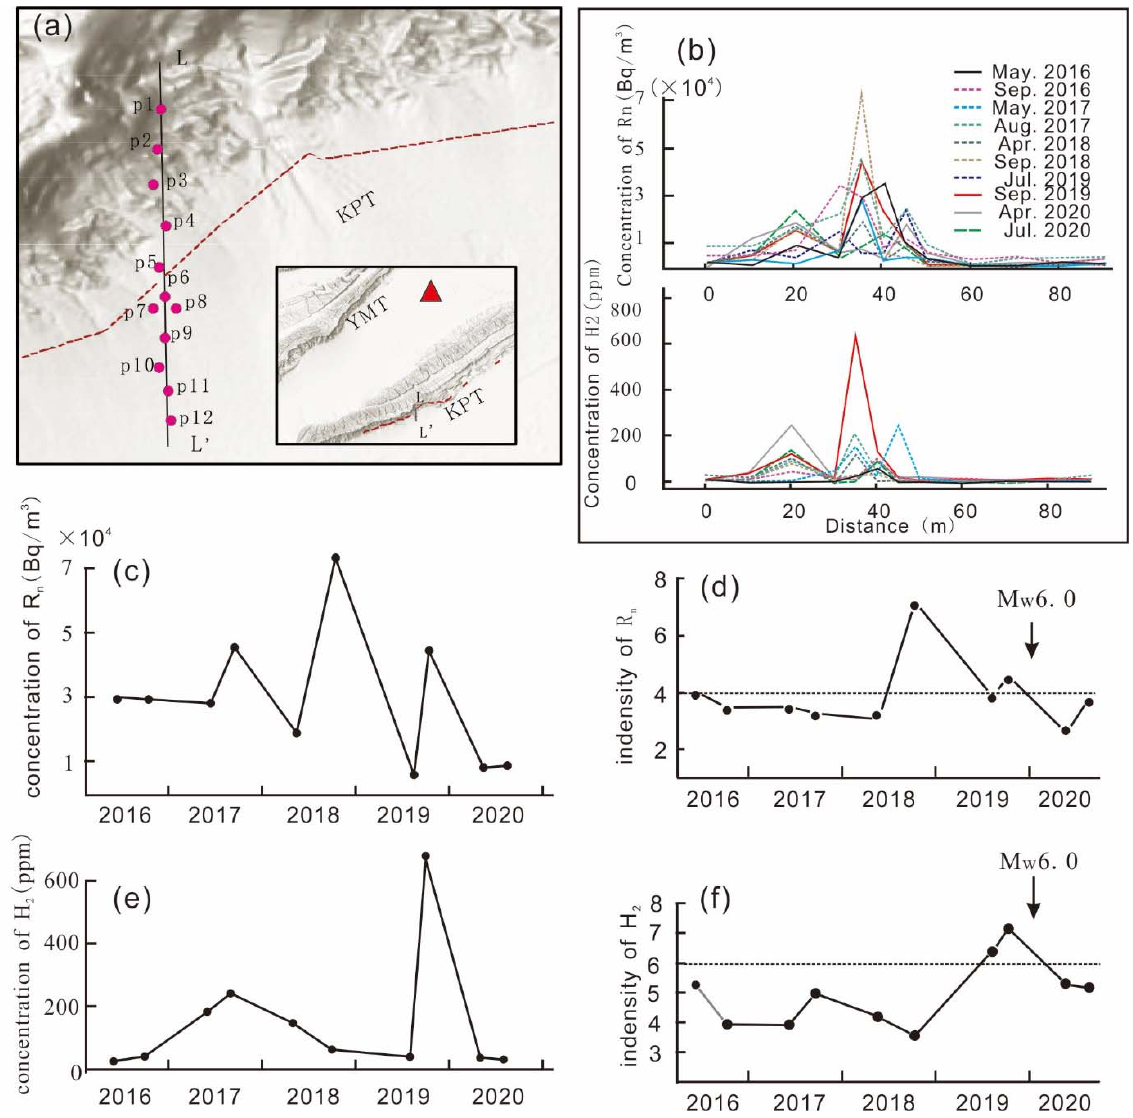
Figure 8. Location of the geochemical survey line (LL”) in the Kalpin region ( a ), where ( b ) shows the radon and hydrogen concentrations, respectively, measured at each monitoring site. Axis of abscissas in ( b ) indicates the distance between the monitoring point andp1. ( c , e ) show the radon and hydrogen concentrations measured at monitoring site p5, respectively, and ( d , f ) show the radon and hydrogen intensities, respectively.